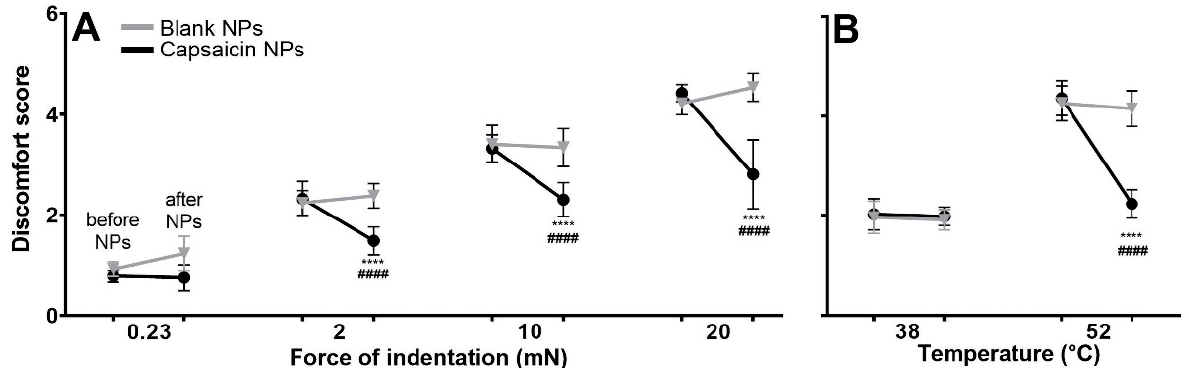
Figure 3. Discomfort scores to mechanical and heat stimuli applied to the cheek. The mechanical stimuli were produced by application of von-Frey type filaments with indentation forces (and tip diameters) of 0.23 mN (67 µm) and 2, 10 and 20 mN (100µm). Heat stimuli were applied by a thermode preheated to the indicated temperature. Each stimulus was applied prior to and 24 h following removal of NPs. (**** p < 0.0001) for significance before and after treatment, #### indicating significant differences between the blank vs. capsaicin NPs groups p < 0.0001, error bars: SD n = 10 male mice per group. RMANOVA—2 within timepoints (before, after treatment) × treatments (capsaicin vs. blank NPs) × forces (0.23, 2, 10, 20 mN) for ( A ) and temperatures for ( B ) (38, 52 °C) with Bonferroni correction.